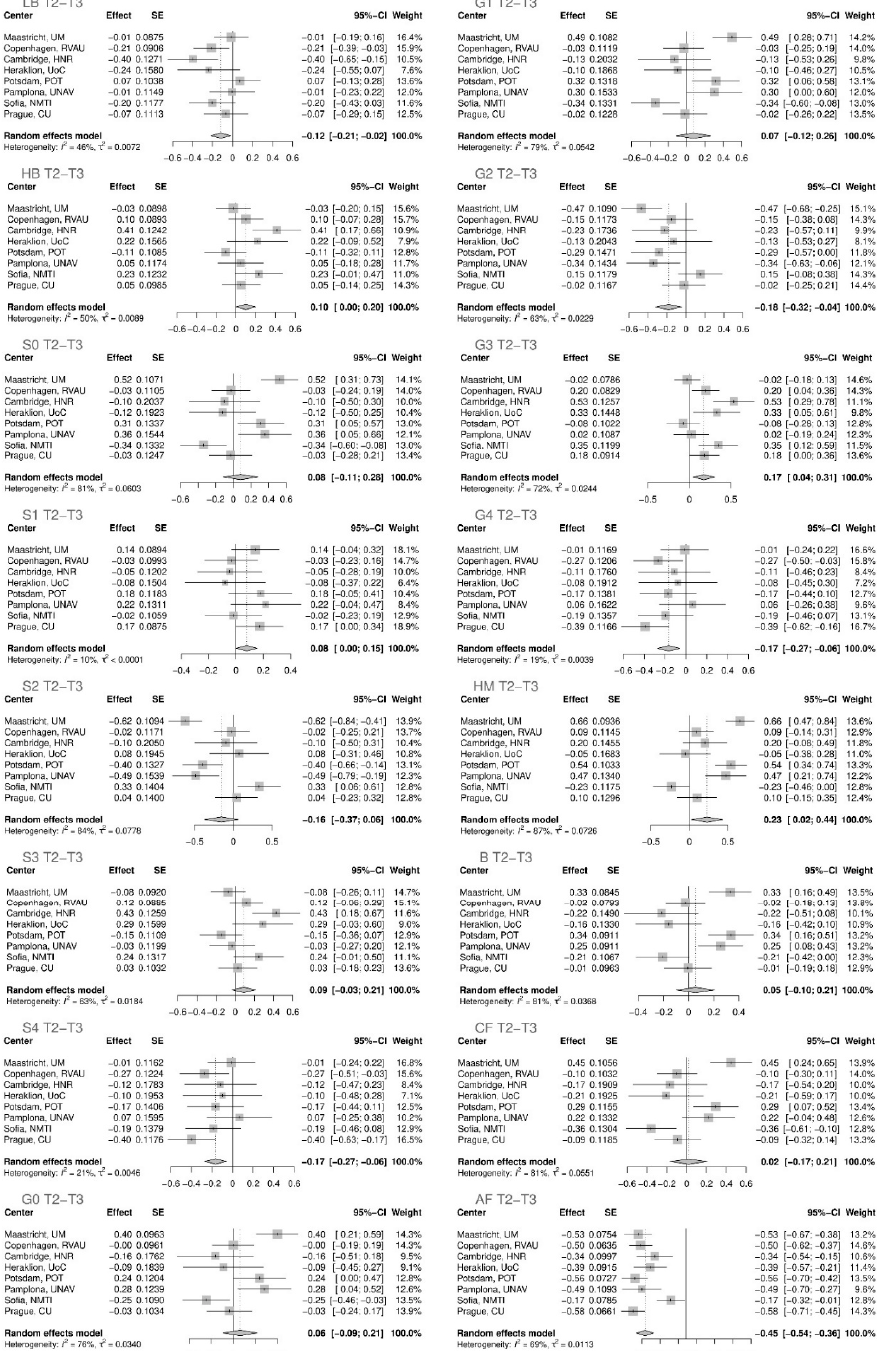
Figure 2. The effect of different weight-maintenance diets on plasma N-glycome in the second time period of 26 weeks (T2–T3). Changes in plasma protein glycome composition after performing meta-analysis for all the centers are shown. SE—standard error; 95% CI–95% confidence